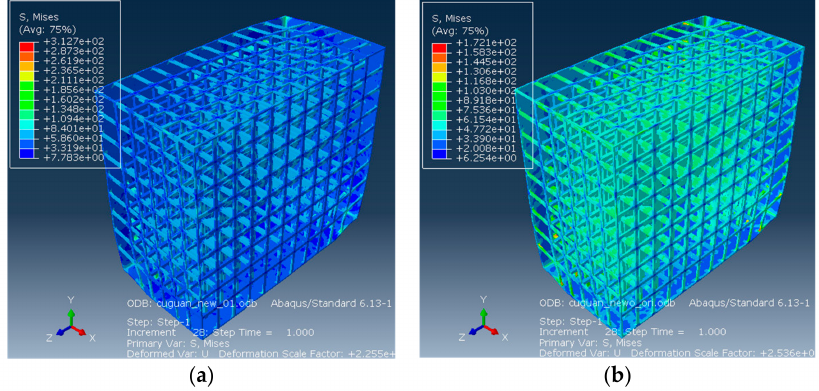
Figure 10. Stress analysis figure for ( a ) the improved storage tank after optimization; and ( b ) the improved storage tank after post-processing.